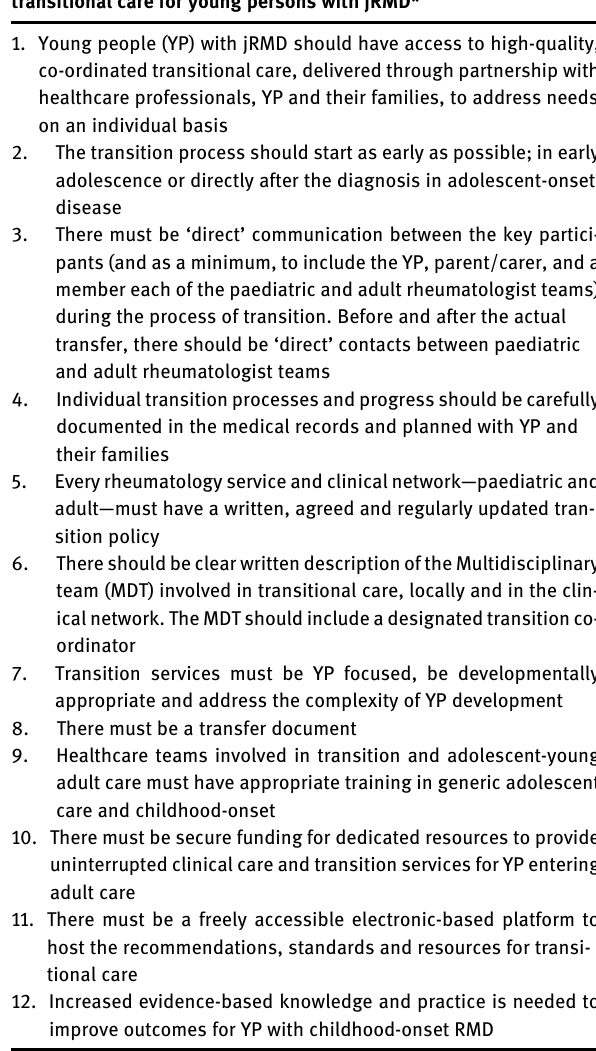
Table  : Recommendations, standards and proposed quality indicators on transitional care for young persons with jRMD (juvenile rheumatic and musculoskeletal